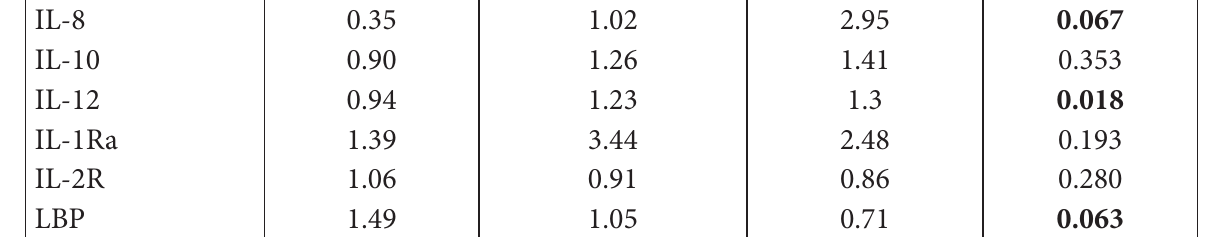
Table 4. Effect of atorvastatin in a subset of participants identified as plasma marker outliers at baseline